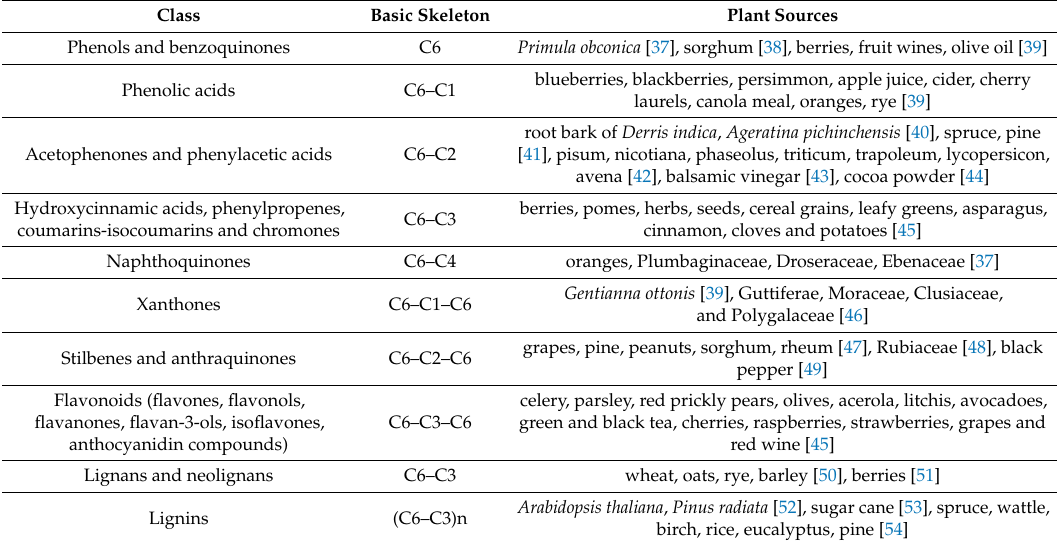
Table 1. Classification of phenolic compounds based on their carbon